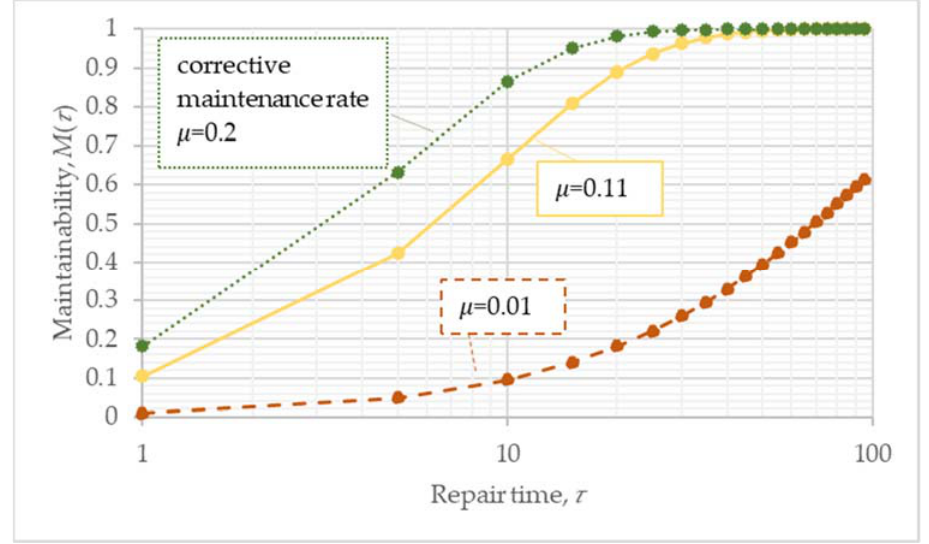
Figure 7. Relationship between repair time 𝜏 and maintainability 𝑀(𝜏) .